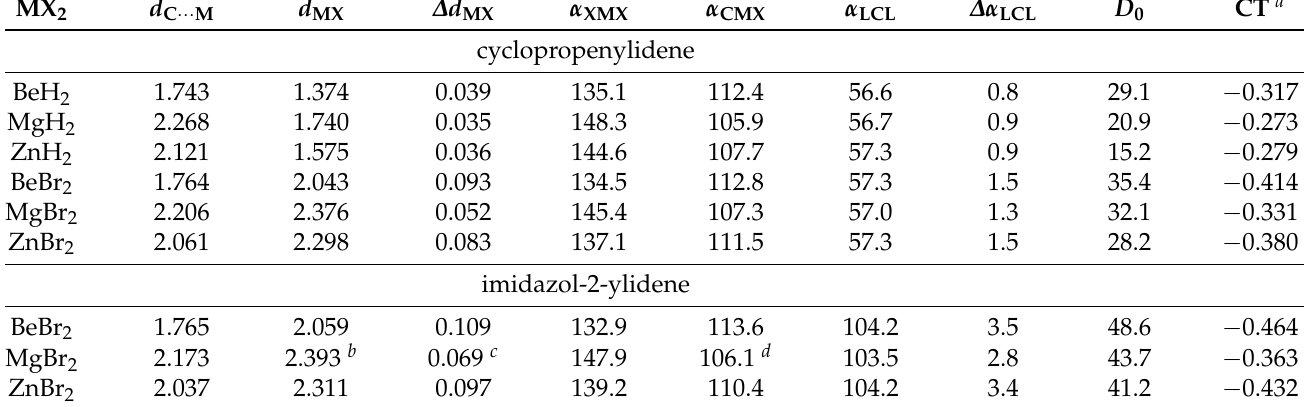
Table 1. Some fundamental data characterizing cyclopropenylidene · · · MX 2 (X = H, Br) and imidazol- 2-ylidene · · · MBr 2 dimers (M = Be, Mg, Zn): C · · · M and M-X distance, change of the MX